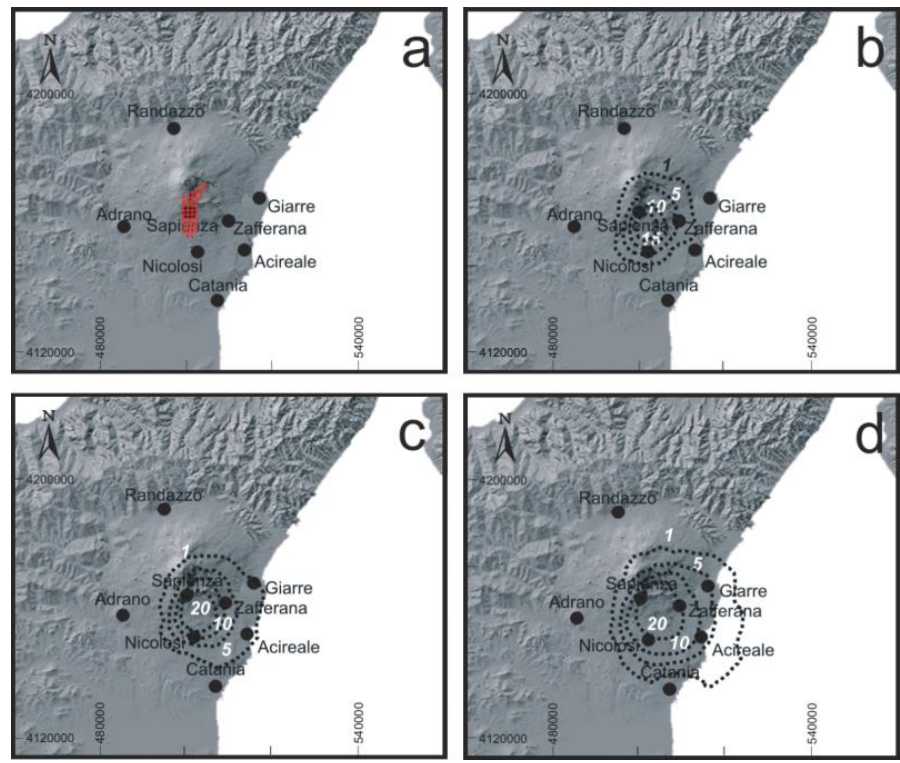
Fig. 14. (a) Location of volcanic vents sampled statistically for the ERS-WLL simulations. Probability maps associated with the ERS-WLL using the thresholds: (b) 300, (c) 200 and (d) 100kgm − 2 .